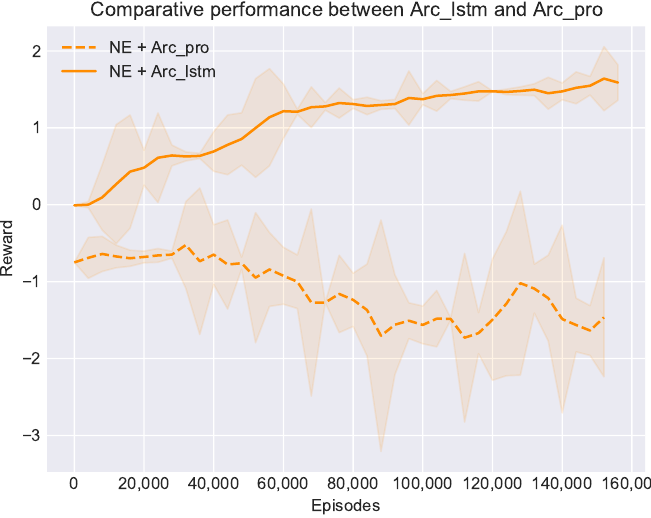
Figure 5. Comparative performance between Arc_pro and Arc_lstm with the same NE method in training against the TP